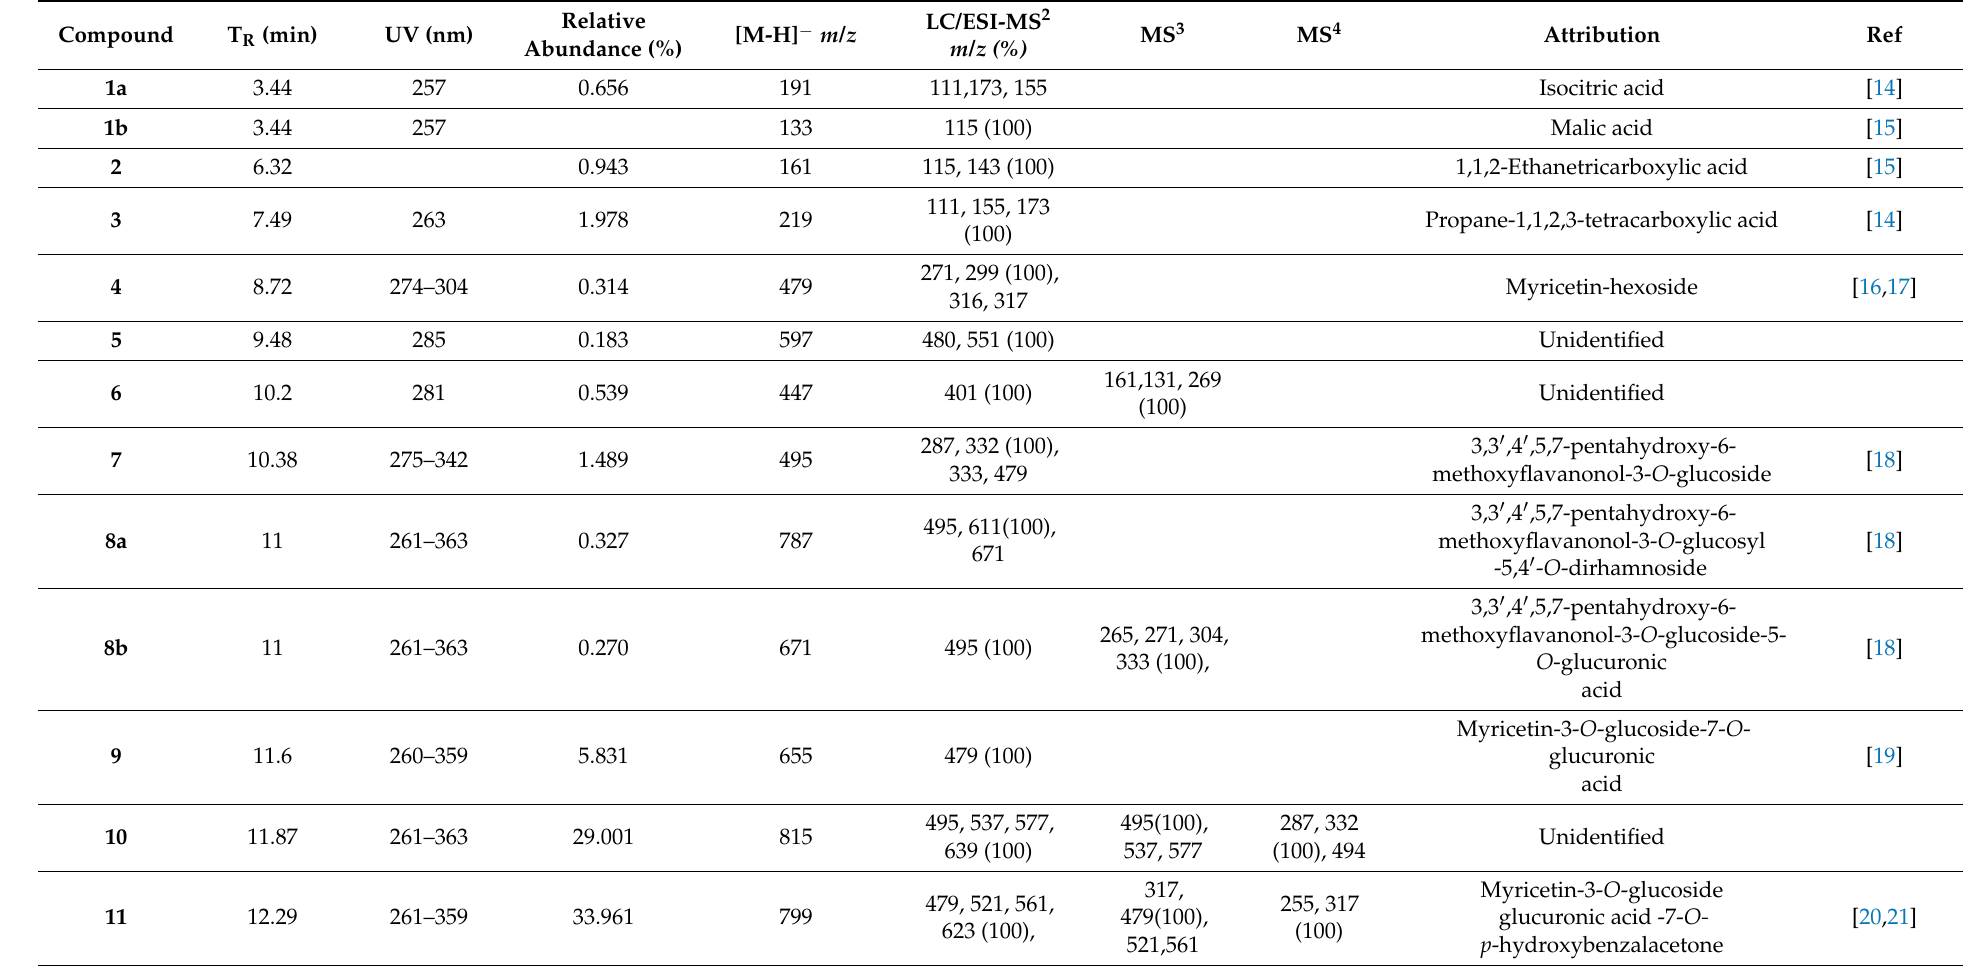
Table 2. Identification of compounds from A. arboreum leaf (EtOH–water, 70/30, v/v ) extract by LC–MS/MS (negative mode). The relative peak area indicates the contribution of each compound to all the identified compounds in the extract, providing a measure of relative